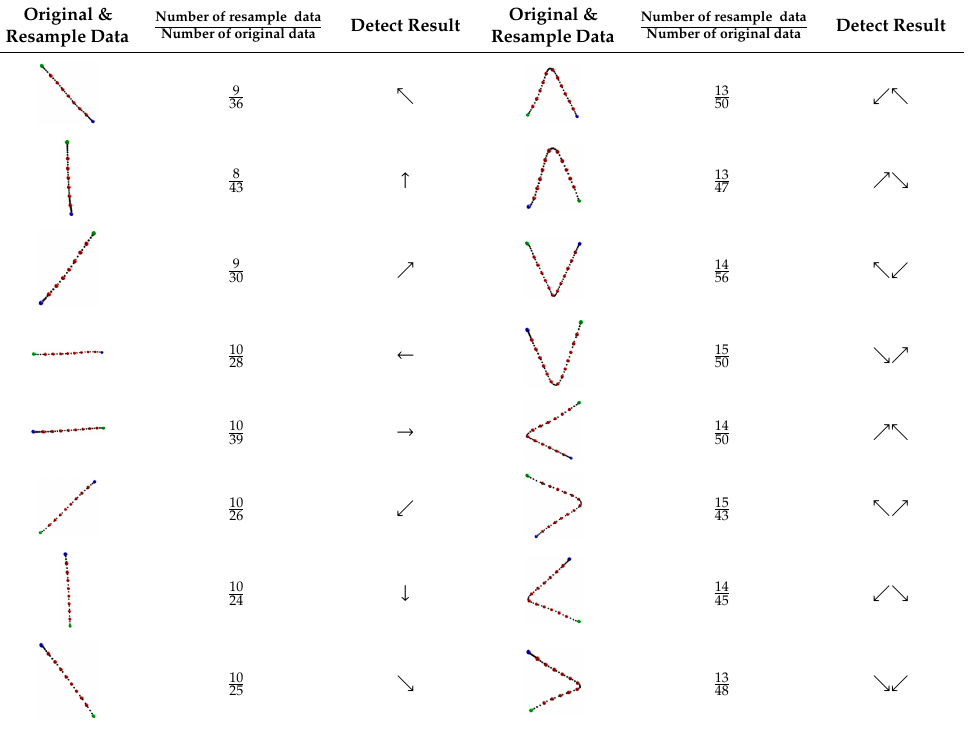
Table 4. Recognition result at normal sampling.